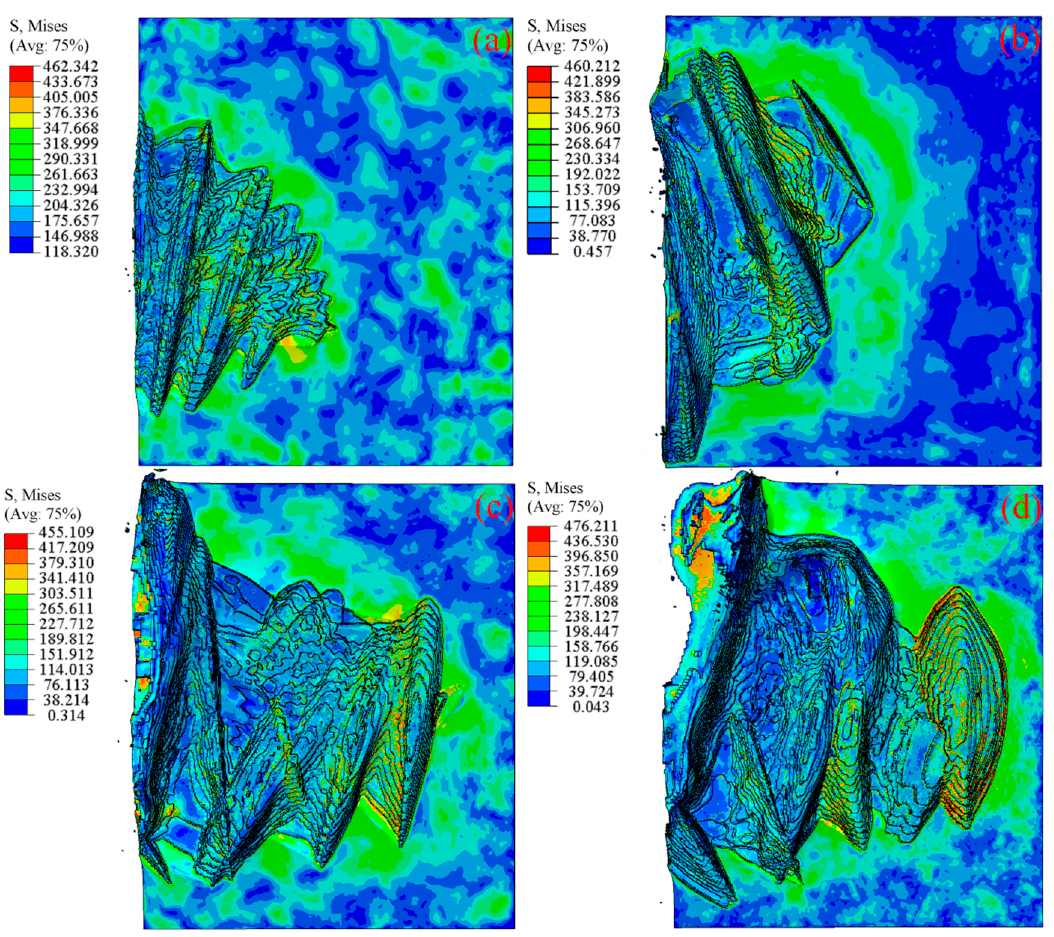
Figure 9. FE simulation results of machined surface morphologies under different spindle